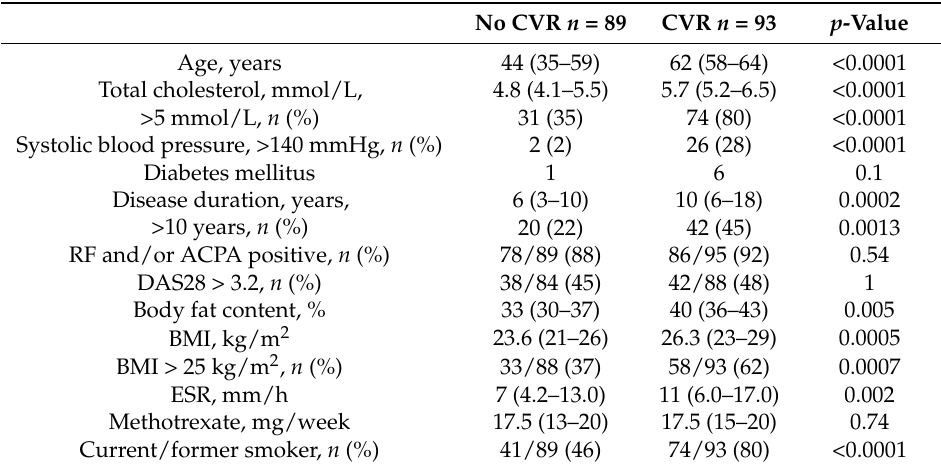
Table 1. Clinical characteristics of RA female patients.